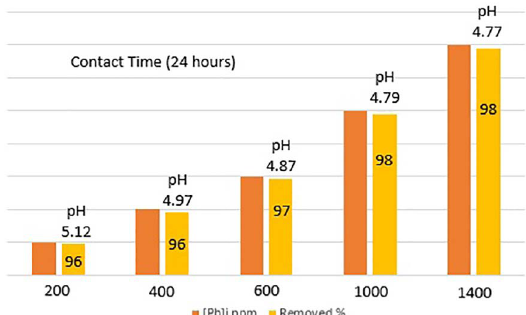
Figure 2. Effect of contact time on the removal of Pb(II) by adsorption onto HA, at different initial concentration.